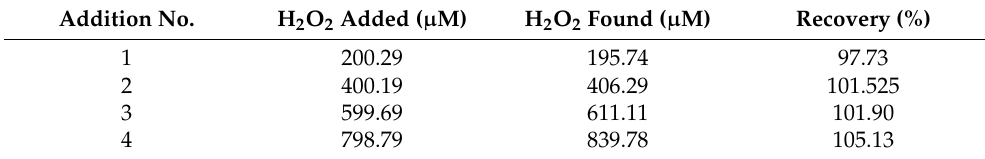
Table 6. Determination of H 2 O 2 in E. coli